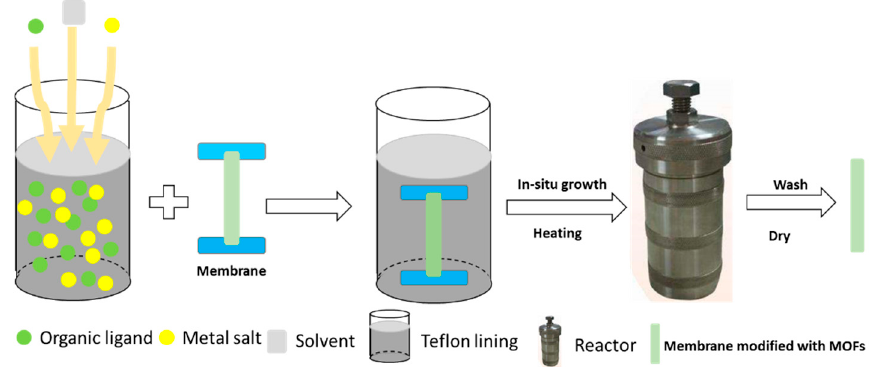
Figure 9. Schematic diagram for the solvothermal synthesis of an MOF-based membrane.